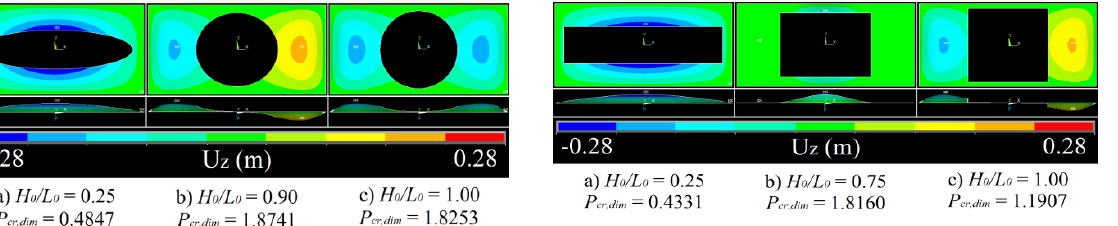
Figure 7. Buckled shape of elliptical perforated plate with hole vol- ume fraction of 0.30.